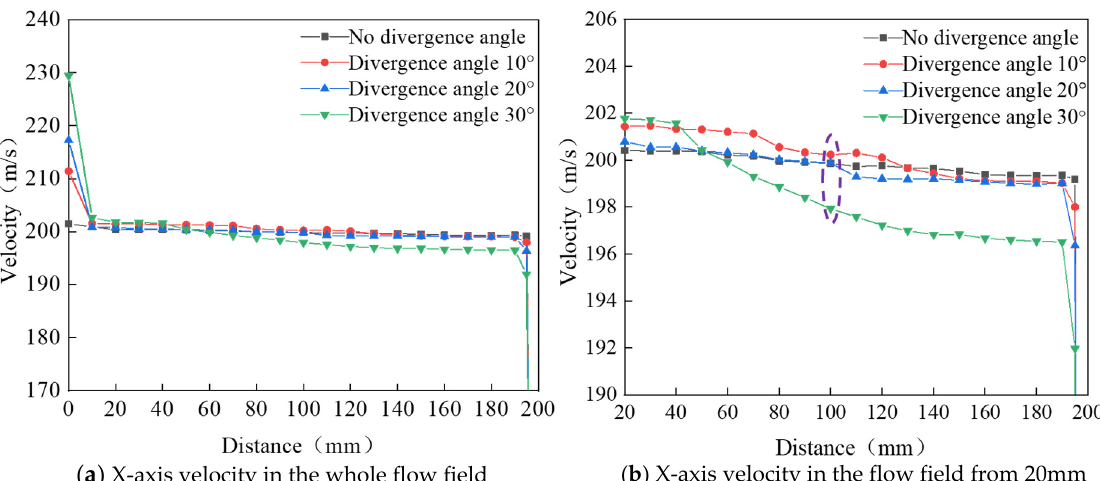
Figure 6. Effect of divergence angle on the X-axis velocity attenuation of the water jet.